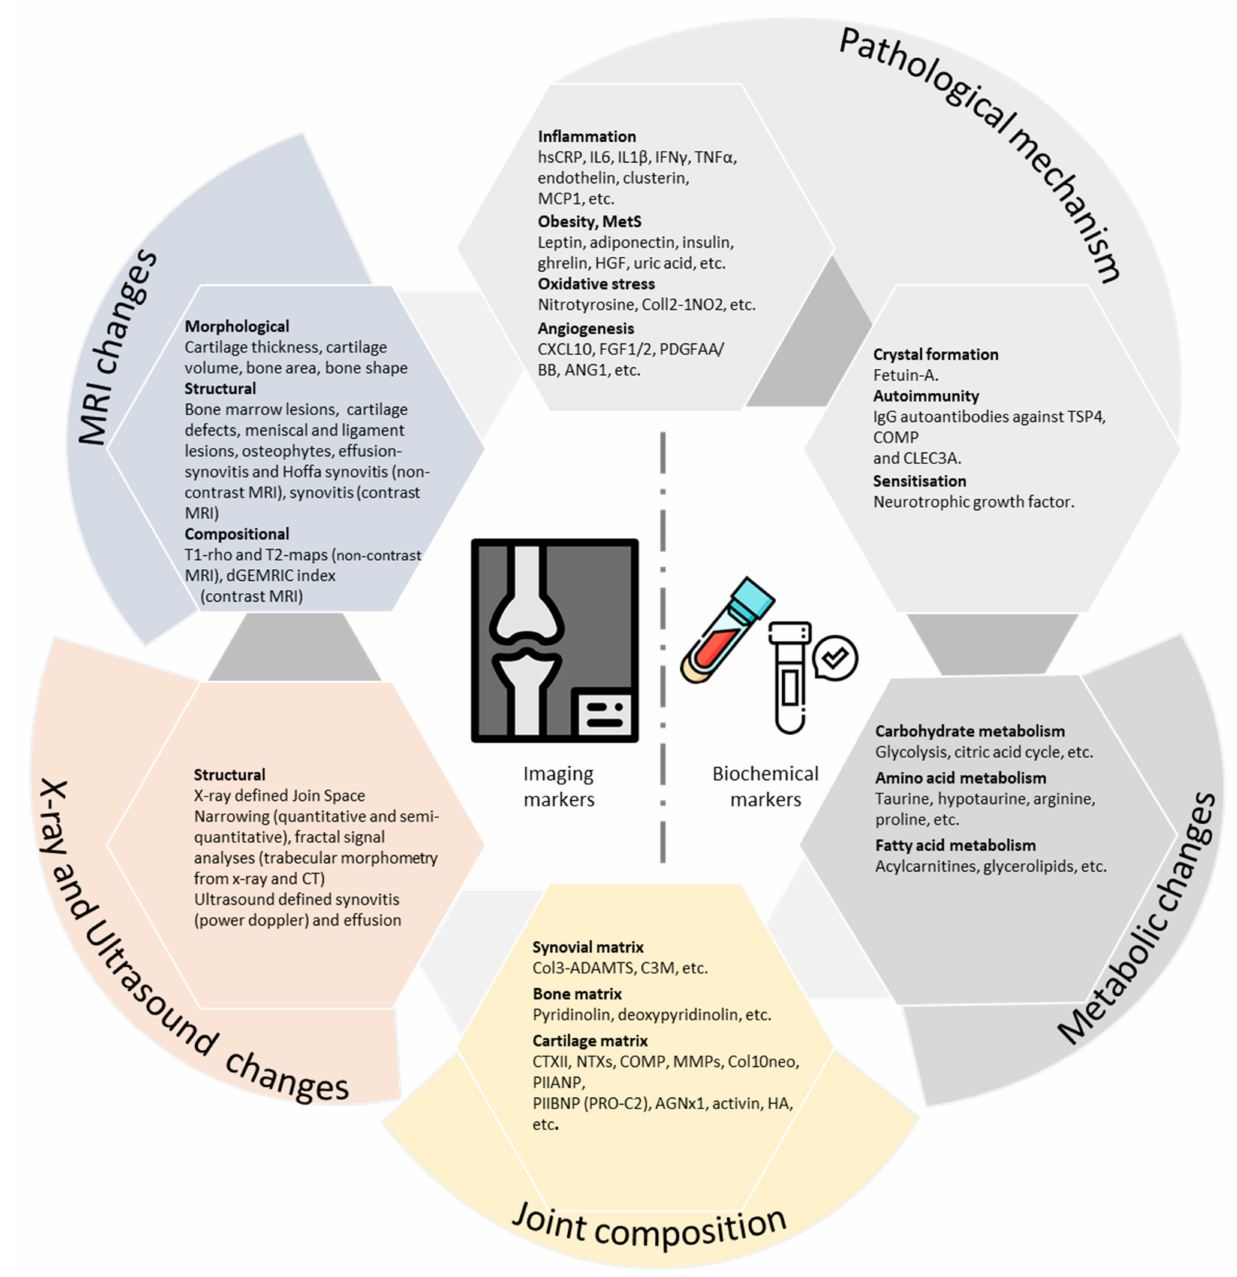
Figure 1. A non-exhaustive representation of osteoarthritis biomarkers. Note: Adapted from: van Spil WE, Szilagyi IA. Osteoarthritis year in review 2019: biomarkers (biochemical markers). Osteoarthritis and cartilage. 1 March 2020;28(3):296- 315. Icon designed by Freepik from www.flaticon.com. Access date: 24 June 2021. AGNx1: ADAMTS-degraded aggrecan; ANG: angiopoietin; BML: bone marrow lesion; C3M: collagen type III degraded by matrix metalloproteinase; CLEC3A: C-type lectin domain family 3 member A; Coll2-1NO2: nitrated epitope of the a-helical region of type II collagen; COL3- ADAMTS: collagen type III cleavage product derived from ADAMTS; Col10neo: collagen typeX neo-epitope; COMP: cartilage oligomeric matrix protein; CTXII: C-terminal cross-linked telopeptide of collagen type II; CXCL10: C-X-C motif chemokine 10; dGEMRIC: delayed gadolinium-enhanced MRI of cartilage; FGF: fibroblast growth factor; HGF: hepatic growth factor, hsCRP: high sensitivity C-reactive protein; IL: interleukin; IFN: interferon; MCP: monocyte chemoattractant protein; MMPs: matrix metalloproteinases; NTX: N-telopeptide crosslinks; PDGF: platelet-derived growth factor; PIIANP, PIIBNP: N-terminal propeptide of type II collagen, splice variants IIA and IIB, respectively; TNF: tumour necrosis factor; TSP: thrombospondin; US: ultrasound; MRI: magnetic resonance